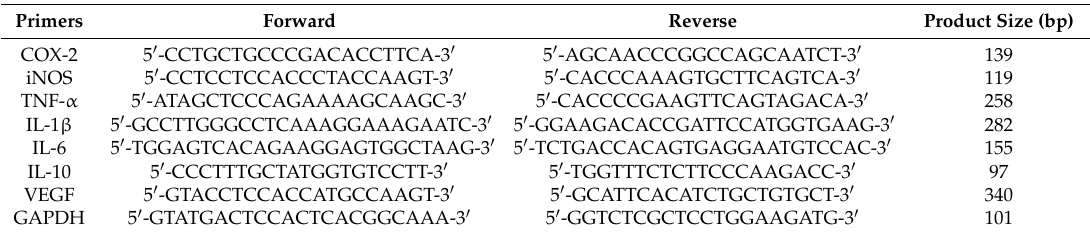
Table 1. Sequences of primers used for semi-quantitative